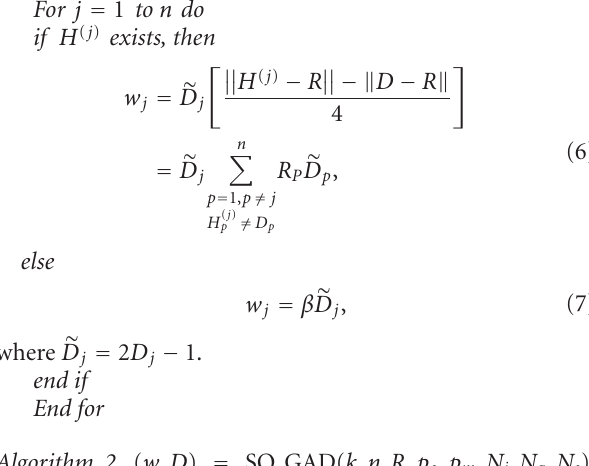
Algorithm 2. ( w , D ) = SO GAD( k , n , R , p c , p m , N i , N g , N s